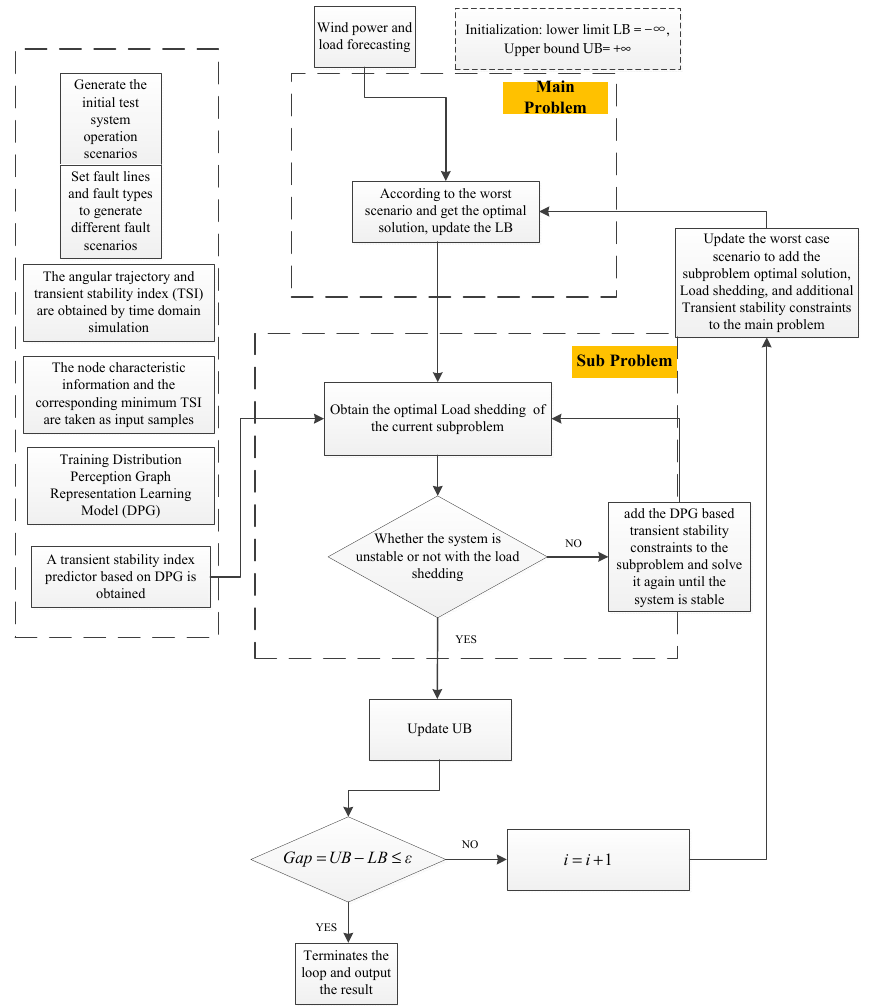
Figure 3. The flowchart of the developed novel solution